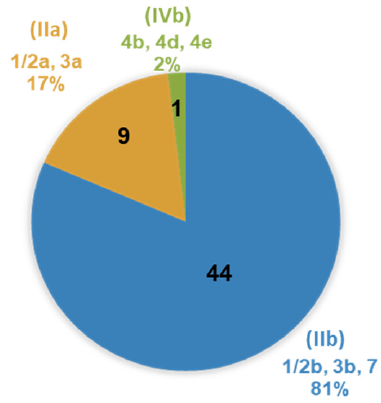
Figure 3. Distribution of PCR-serogroups and serotypes (ser.) of L. monocytogenes isolates recovered during microbiological monitoring of surfaces and end-products in a cheese processing facility. Dis- tribution comprises of PCR-serogoups IIa: ser. 1/2a, 3a; IIb: ser. 1/2b, 3b, 7; IVb: ser. 4b, 4d, 4e, with the total number of strains and recovery percentages for each serogroup embedded in the chart.